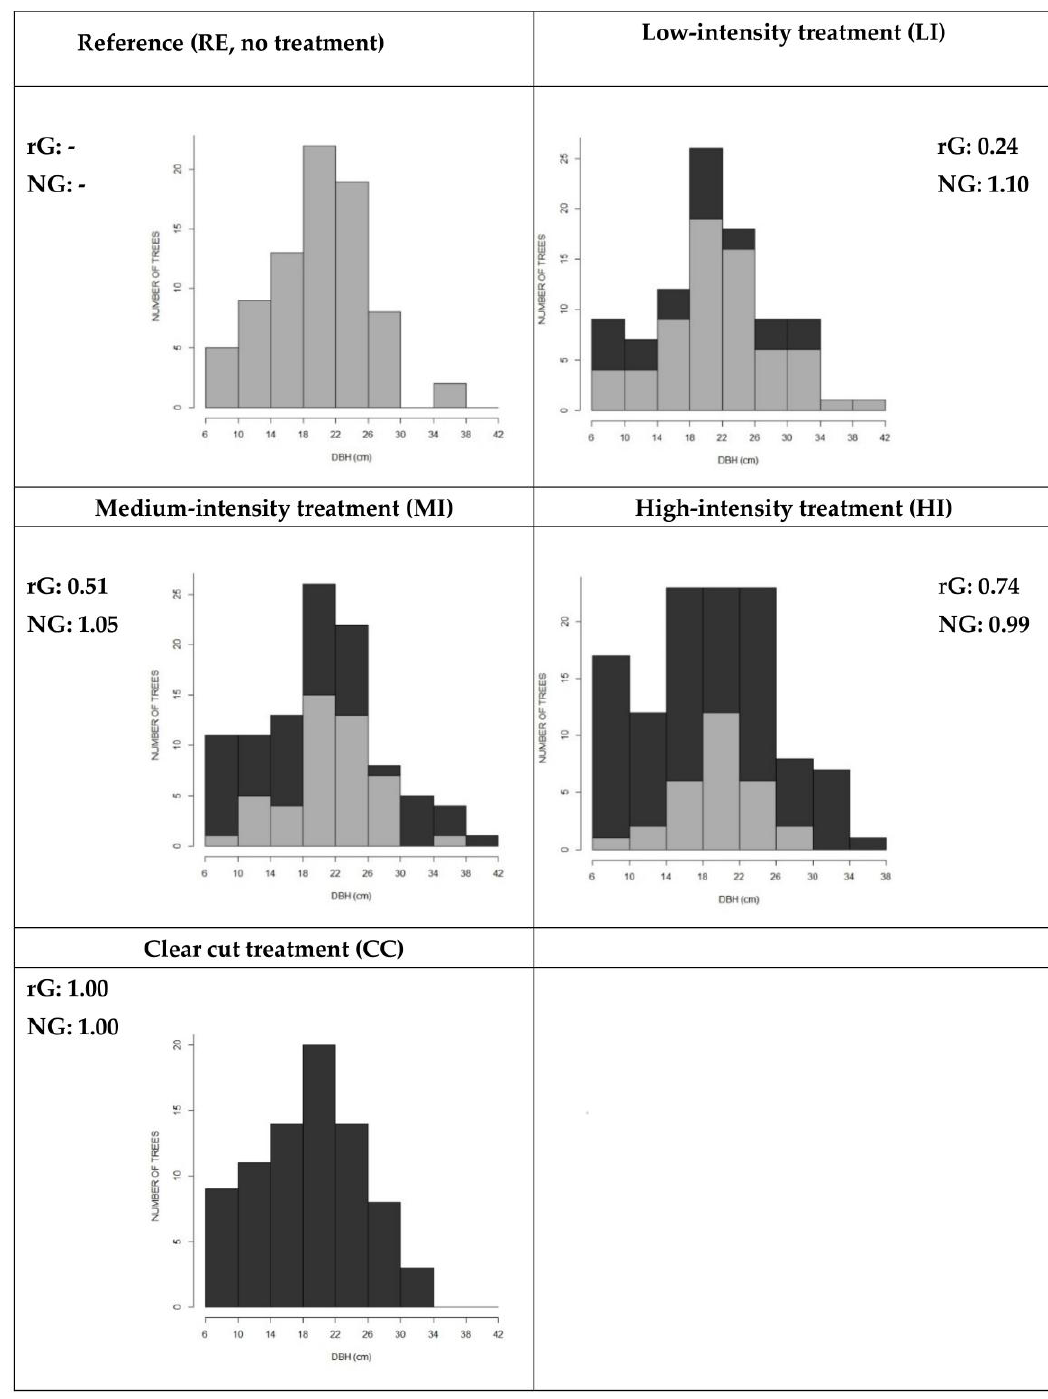
Figure 3. Characterization of the different selective logging treatments in 1998; grey: trees remaining after logging; black: trees removed during logging; rG = selective logging weight (logging intensity); NG = selective logging